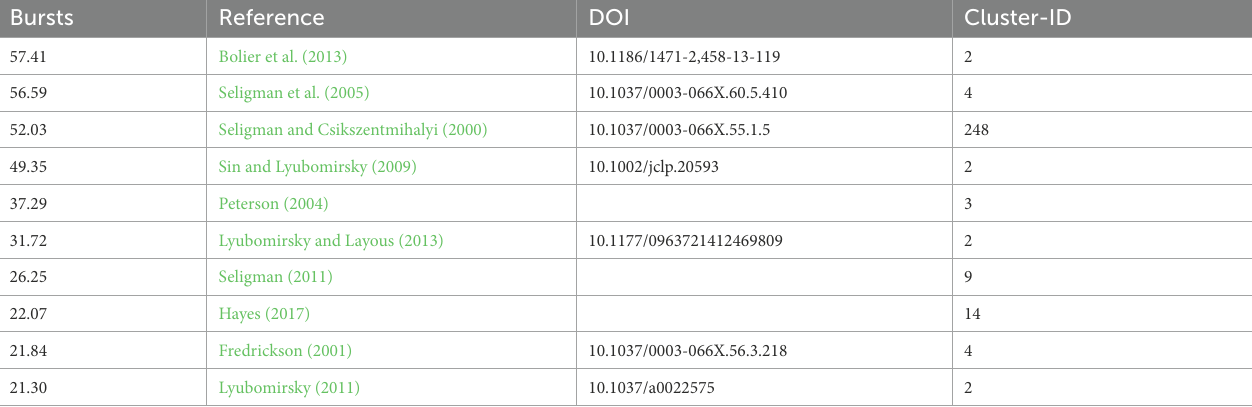
TABLE 6 Top 10 co-cited references in positive psychology research in terms of citation bursts.